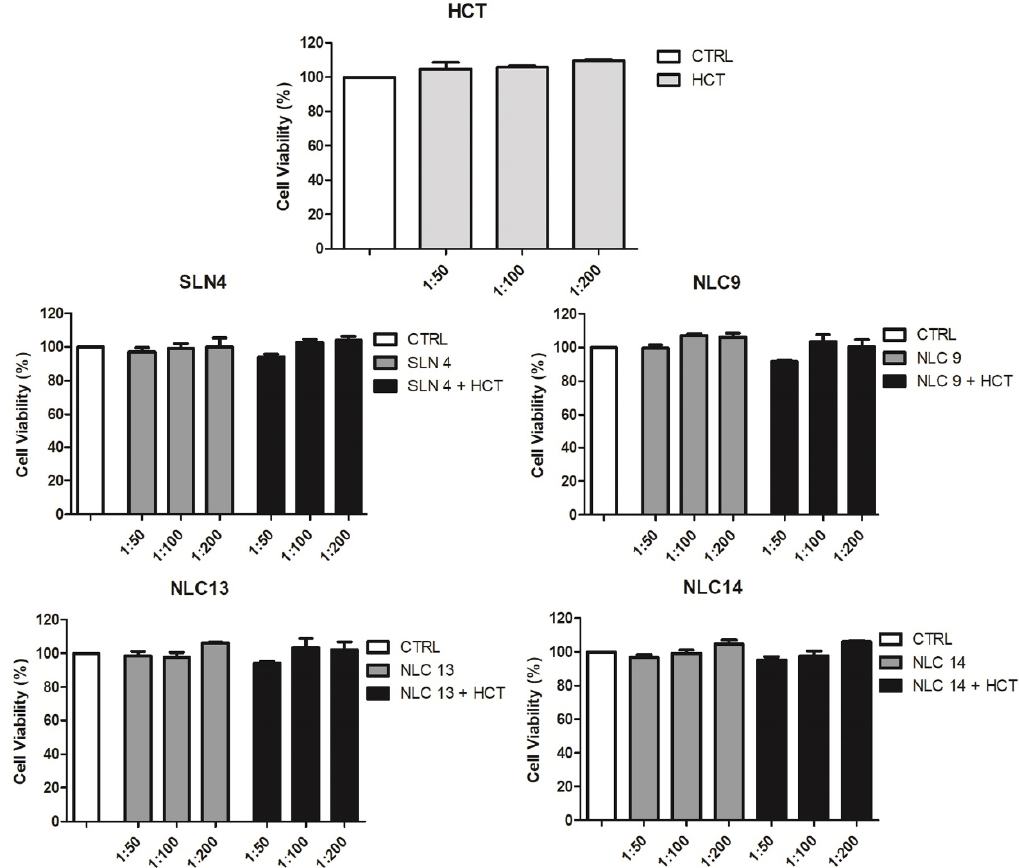
Figure 6. Cytotoxicity on CaCo-2 cell line expressed as cell viability % of pure HCT, empty and drug-loaded SLN4, empty and drug-loaded NLC9, NLC13, NLC14 at different dilutions (1:50, 1:100, 1:200) after 24 h exposure.